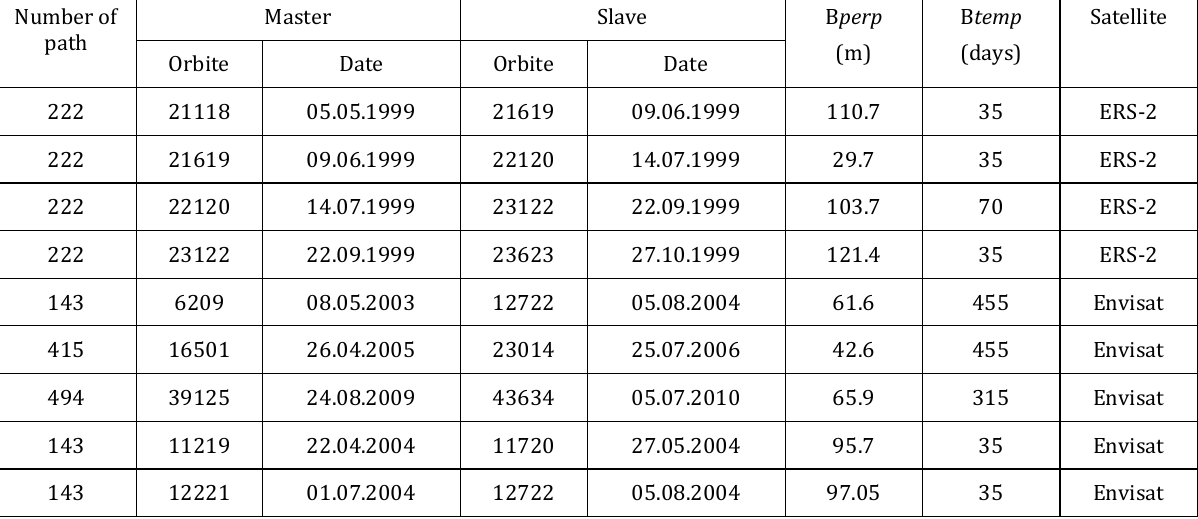
Table 1. Information about the used radar images for Figs. 1, -2, -3, -4. B perp : perpendicular baseline in metres, B temp : temporal